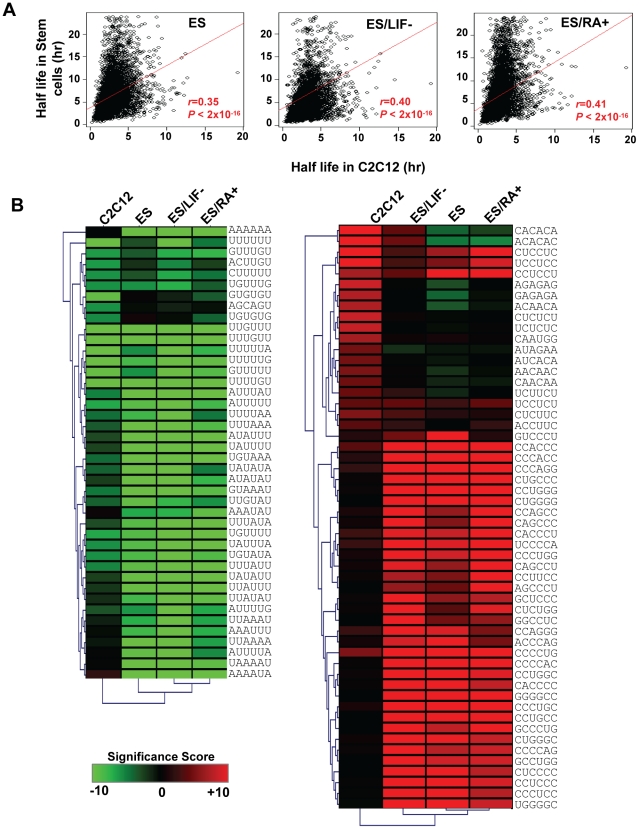
mRNA decay is influenced by different elements in different cell types.(A) Scatter plots comparing mRNA half lives in C2C12 with those in pluripotent and differentiating embryonic stem (ES) cells [10]. ES/LIF− and ES/RA+ represent ES cells differentiated by withdrawal of Leukemia Inhibitory Factor (LIF) and addition of Retinoic Acid (RA), respectively. Pearson correlation coefficient (r) and P-value for linear regression are shown for each plot. (B) Heat maps showing significance of hexamers associated with mRNAs with short (left panel) and long (right panel) half lives in C2C12, ES, ES/LIF−, and ES/RA+. Top 20 ranked hexamers for each cell type were selected and combined to illustrate variable significance in different cells. Each hexamer has a Significance Score (SS). SS = −log(P-value)*s, where P-value was derived from Fisher's exact test, and s = 1 if the hexamer is significantly associated with mRNAs with short half life, and  = −1 otherwise. SS are shown in the heat map with color according to the scale shown in the figure. Hexamers were clustered (Euclidean distance and average linkage) for easy visualization.